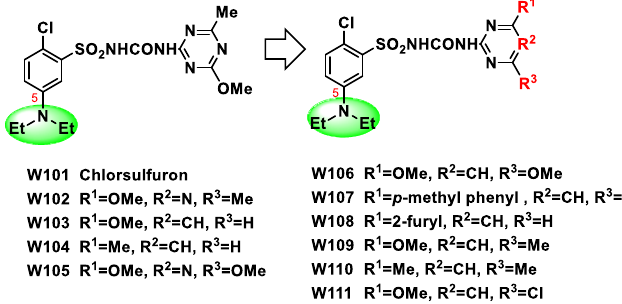
Figure 2. Design of the title compounds W.